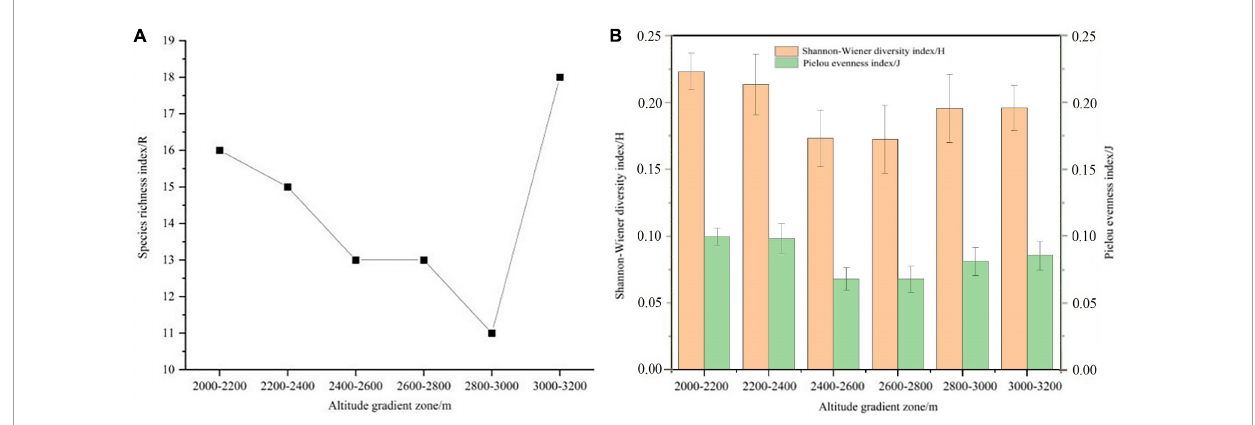
FIGURE4 α diversity index of herbaceous plants in different altitude gradients of shady slope. (A) Species richness index, and (B) Shannon-Wiener diversity index and Pielou evenness index.